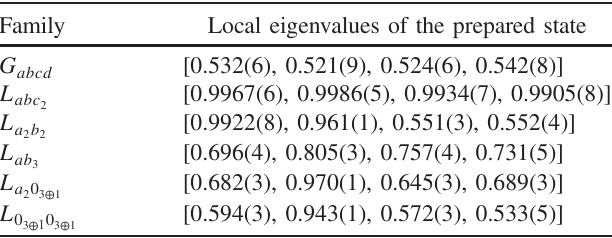
TABLE I. Four-qubit entanglement classes: The first column specifies the distinct families, while the second one accounts for the local maximum eigenvalues of the reduced density matrices using the notation of Ref. [5]. Some of these families present an infinite number of classes. Therefore, we are referring here to just one of the classes in the